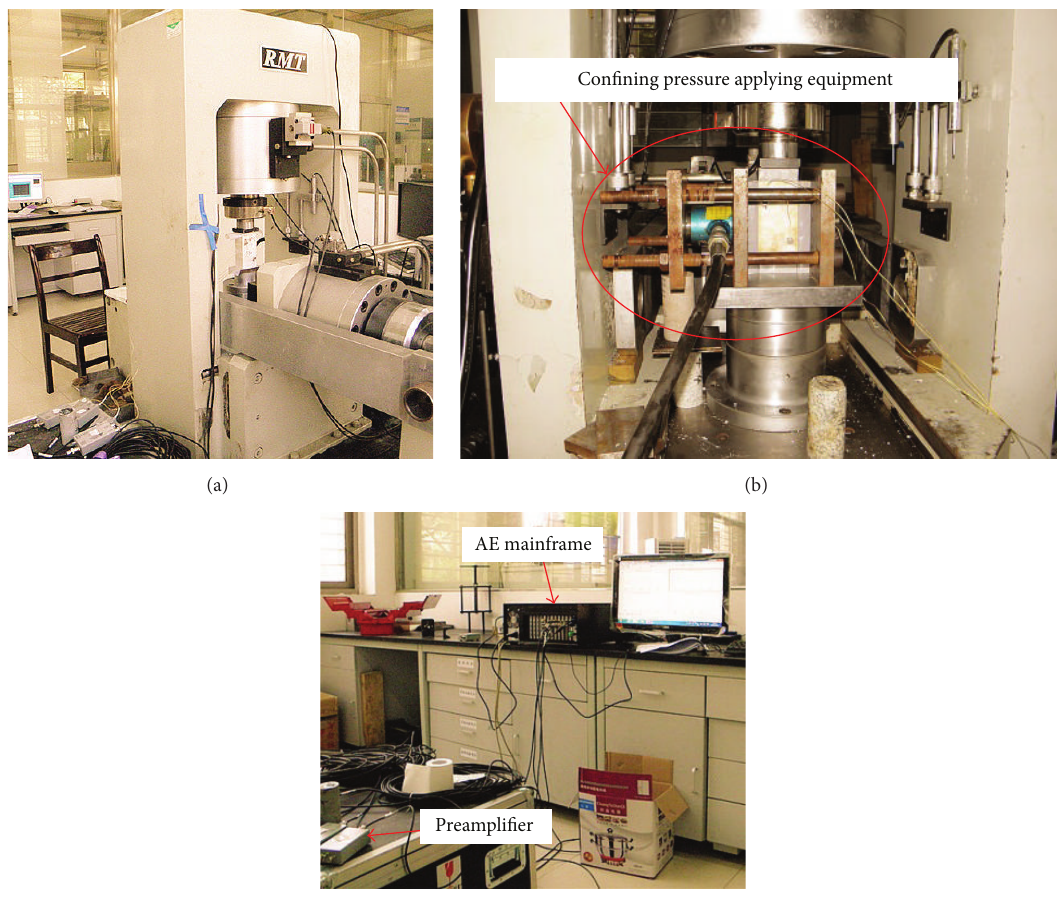
Figure 3: Different testing equipment. (a) RMT-150C rock mechanics servo-controlled testing system. (b) Confining pressure applying system. (c) AE monitoring